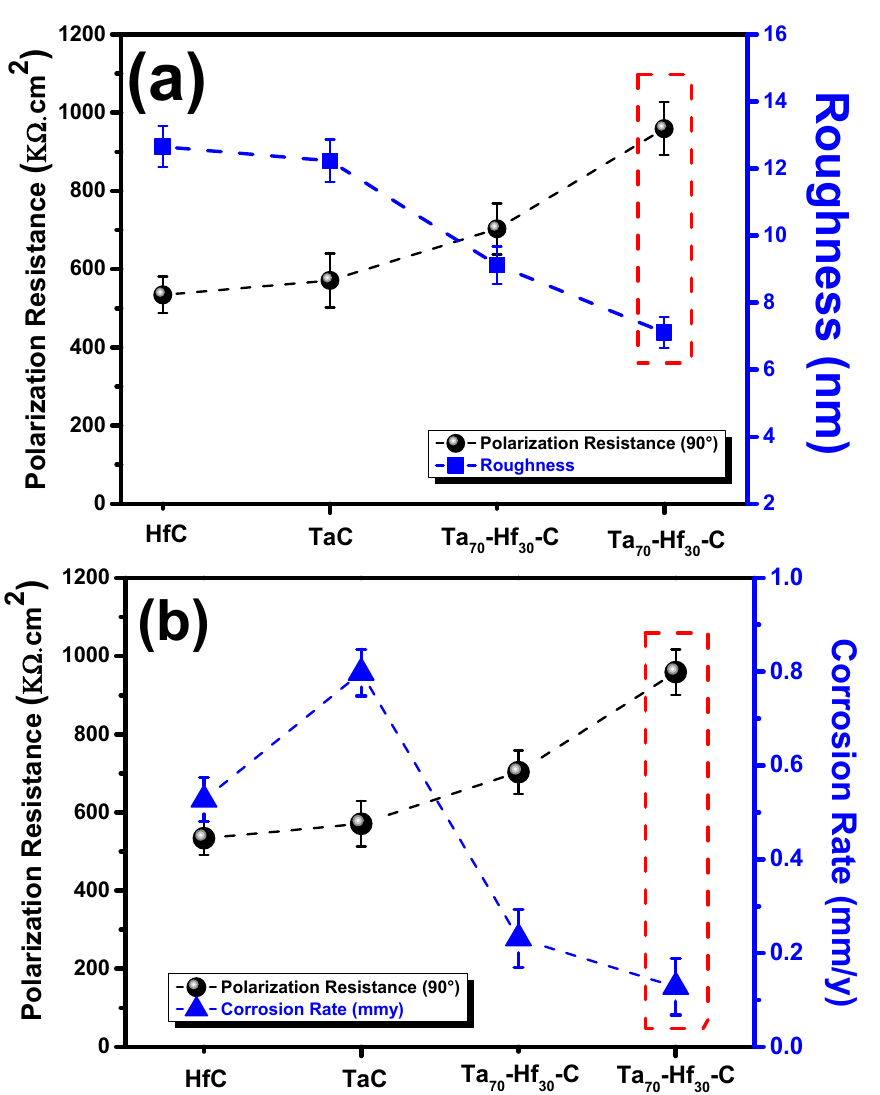
Figure 19. Merit index for different properties: ( a ) polarization resistance (90°) vs. roughness and ( b ) polarization resistance (90°) and corrosion rate.